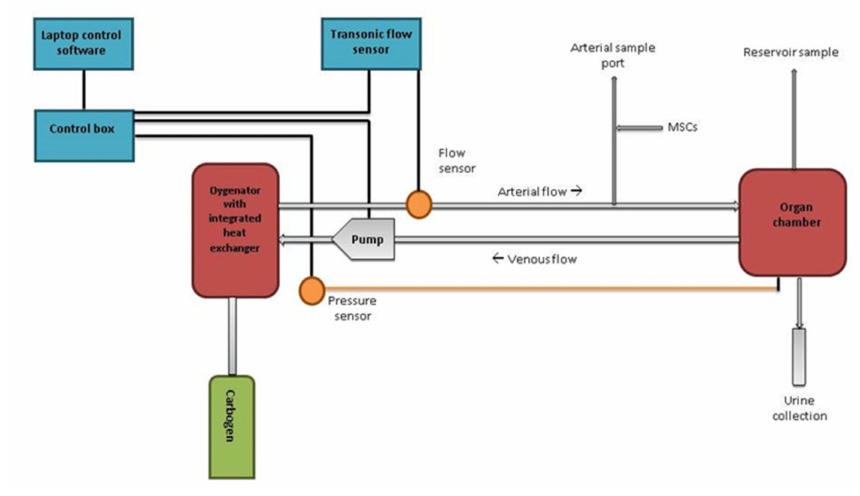
Figure 6. Schematic overview of the normothermic machine perfusion